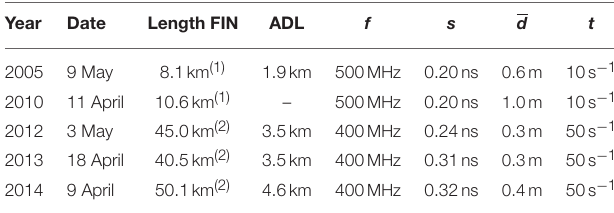
(1) Arbitrary profile lines, (2) Regular 500